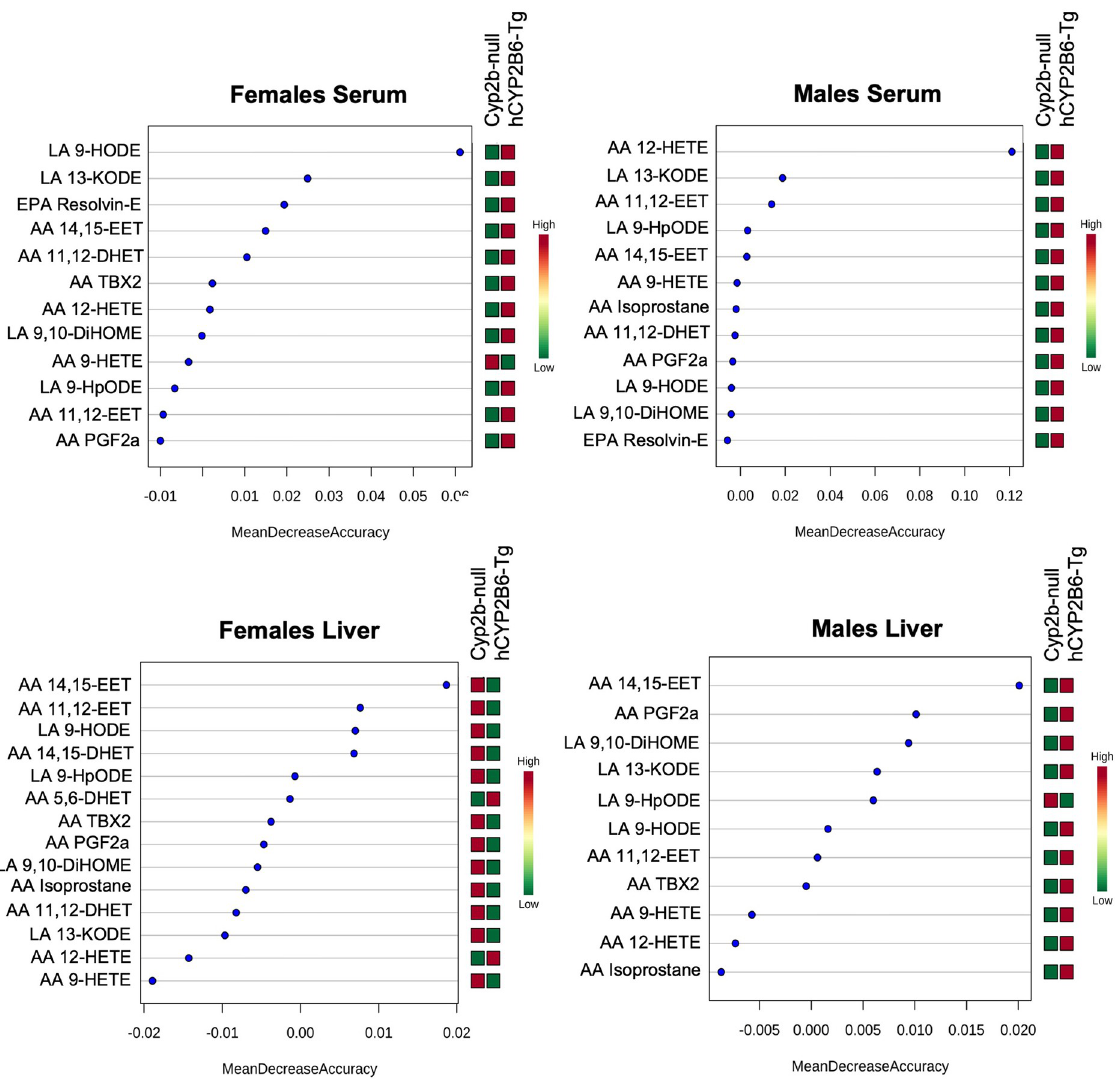
Fig 5. Random forest analysis of lipid metabolites by tissue type in female and male mice. Important lipid metabolites identified by random forest analysis between Cyp2b-null and hCYP2B6-Tg mice in serum or liver tissue.